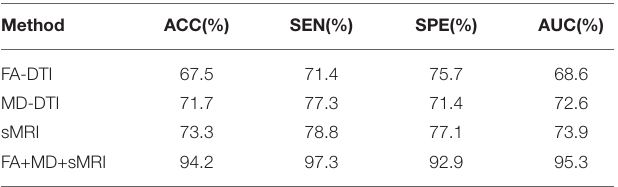
TABLE 2 | Classification performance comparison between the single-modality and multi-modality method for distinguishing EMCI from NC.